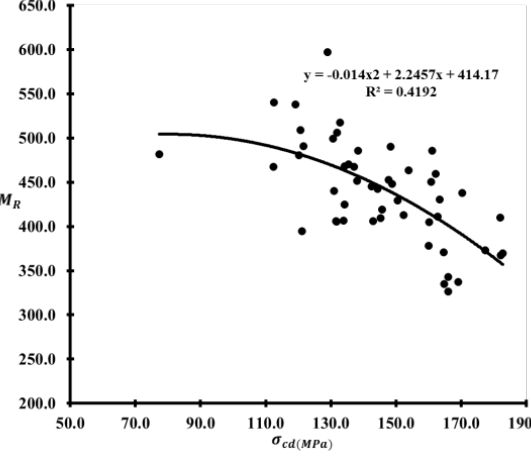
and Fig. 15. Relationship between M and R and  (%) Fig. 13. Relationship between M and  R cd R cd 𝜎𝜎 𝑐𝑐𝑐𝑐 and  𝜀𝜀 𝑎𝑎 (cid:3) 𝑚𝑚𝑎𝑎𝑚𝑚 and s . R cd R cd 𝑀𝑀 𝑅𝑅 𝜎𝜎 𝑐𝑐 𝜀𝜀 𝑐𝑐𝑐𝑐